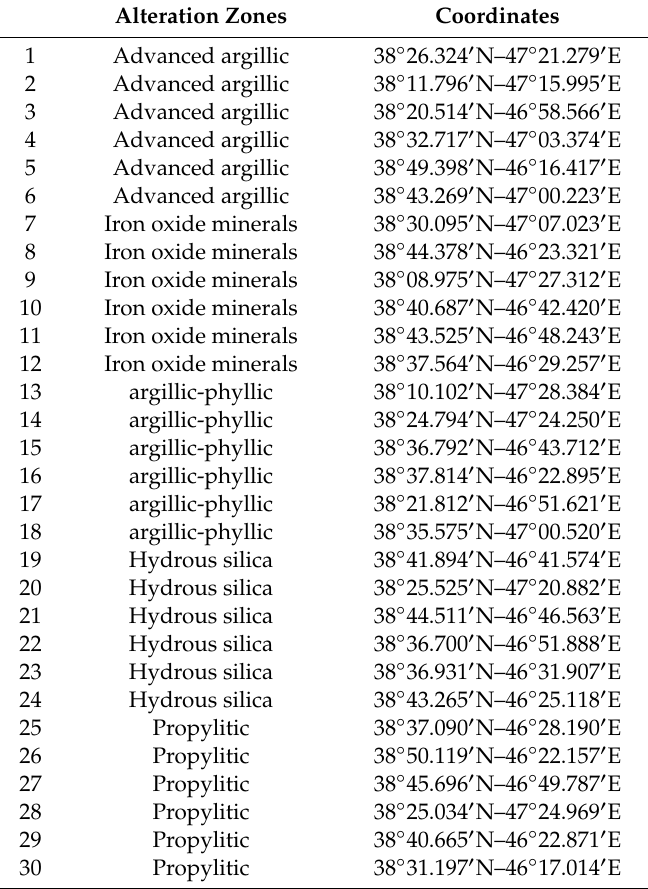
Table 6. Locations of representative hydrothermal alteration zones recorded by systematic GPS survey during fieldwork in the study area.